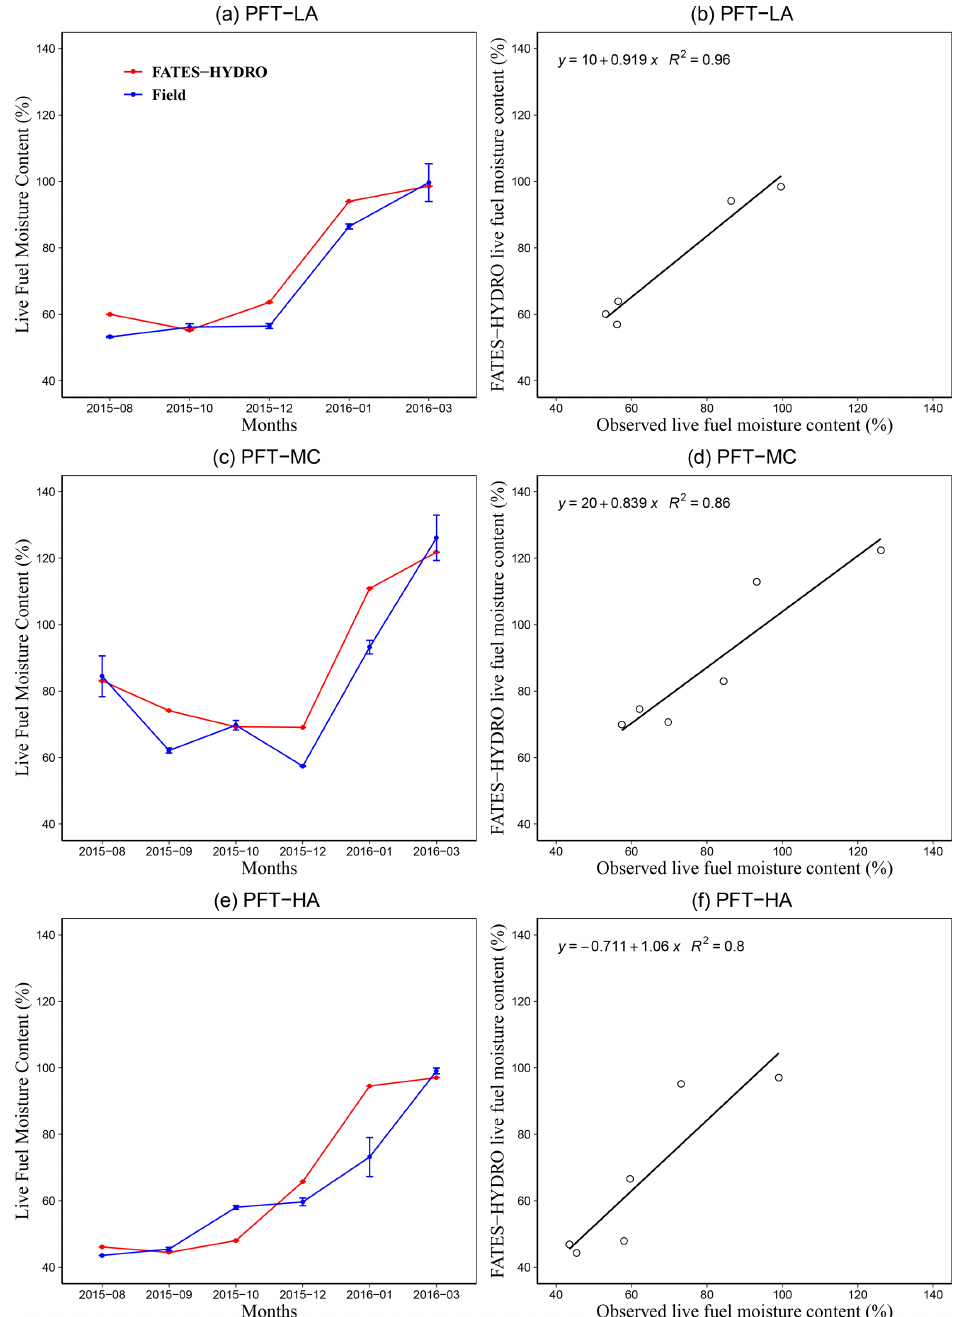
Figure 2. Simulated and observed monthly live fuel moisture content and related R 2 values for three PFTs (see Fig. 1 for an explanation of the